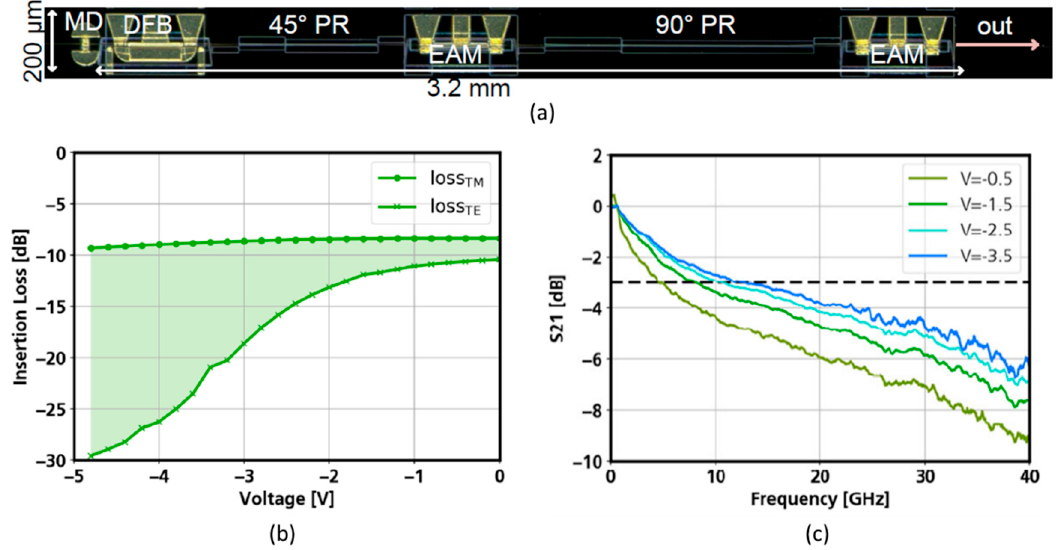
Figure 3. Photograph of the fabricated dual-polarization electro-absorption-modulated laser ( a ), along with a plot showing the insertion loss of the EAM for bot polarizations ( b ), and a plot of the bandwidth of the EAM for various applied voltages ( c ).